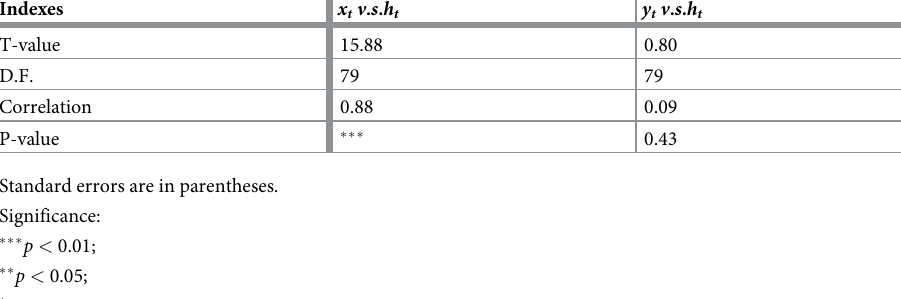
Table 3. The result of correlation analysis of quarterly CPI with one phase lag and quarterly GDP.